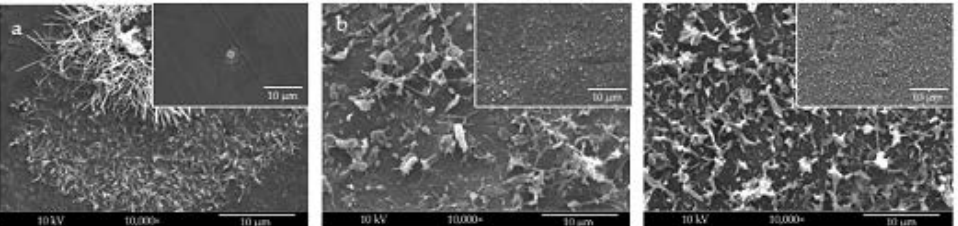
Figure 1. SEM micrographs of electrosprayed sCNs on the aluminum using different solvent sys- tems: ( a ) distilled water, ( b ) distilled water/acetic acid (50/50 w / w ), and ( c ) distilled water/HFIP (60/40 w / w ). Main pictures show zoomed-in (10,000 × ), while lenses show zoomed-out (1000 × ) magnifications.